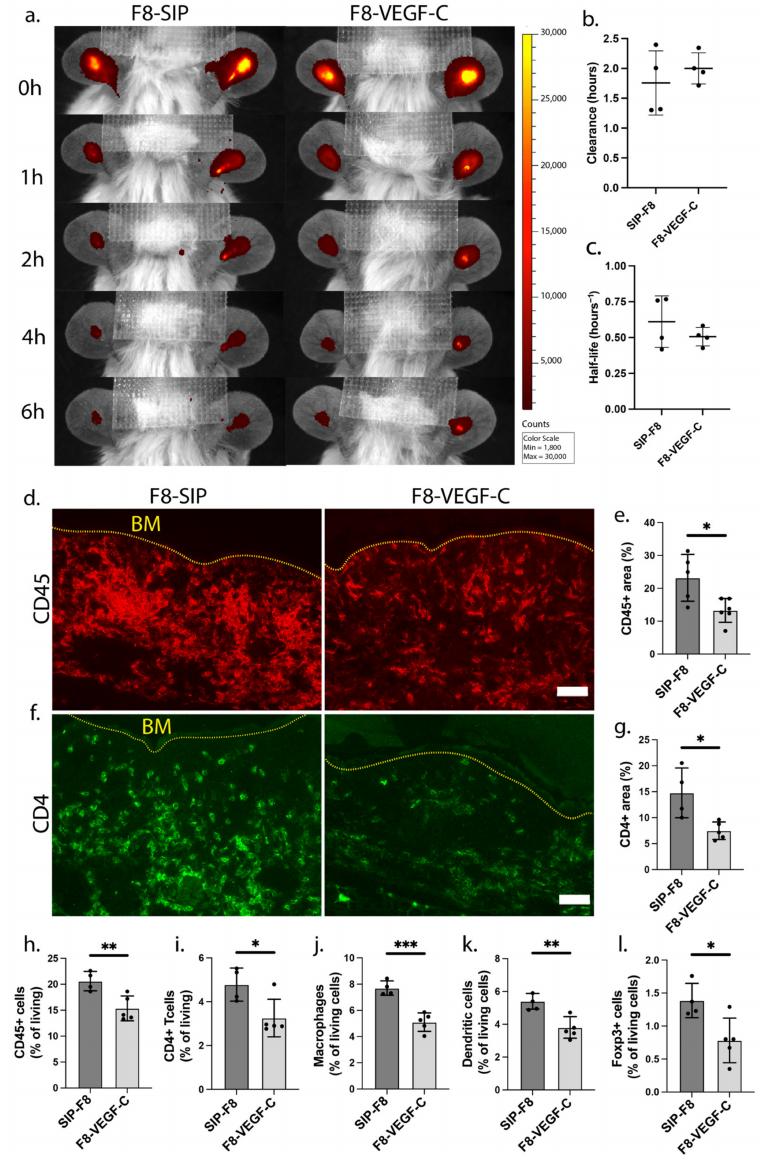
Figure 4. ( a ) Representative IVIS-images showing clearance of the intradermally injected near- infrared dye P20D800 in K14-VEGF-A transgenic mice initially treated with either F8-SIP or F8-VEGF- C, 10 days after re-challenge. ( b ) Clearance rate and ( c ) half-life of the P20D800 tracer in F8-SIP and F8-VEGF-C-treated K14-VEGF-A transgenic mice 10 days after re-challenge (expressed as mean clearance rate resp. half-life, n = 4 mice per group, two-tailed Student’s t -test). ( d , e ) Representa- tive immunofluorescence images ( d ) and quantification ( e ) of ears from F8-SIP and F8-VEGF-C- treated K14-VEGF-A transgenic mice stained for CD45 (red) (expressed as mean %, n = 5–6 mice per group, two-tailed Student’s t -test, one representative of two independent experiments is shown). ( f , g ) Representative immunofluorescence images ( f ) and quantification ( g ) of ears stained for CD4 (green) (expressed as mean %, n = 5–6 mice per group, two-tailed Student’s t -test, one representative of two independent experiments is shown). ( h – l ) Quantification of total CD45 + cells ( h ) and immune cell subsets ( i ) CD4 + Foxp3 - (T helper cells), ( j ) CD11b + F4/80 + (macrophages), ( k ) CD11c + MHCII + (dendritic cells), and ( l ) CD4+ Foxp3 + (regulatory T cells) in F8-SIP and F8-VEGF-C-treated K14- VEGF-A transgenic mice 10 days after re-challenge (expressed as % of all living cells, n = 4–5 mice per group, two-tailed Student’s t -test, one representative of two independent experiments shown). Dotted yellow line: basement membrane (BM). Size bars: 50 µ m. All data are presented as mean ± SD. * p < 0.05, ** p < 0.01, *** p <